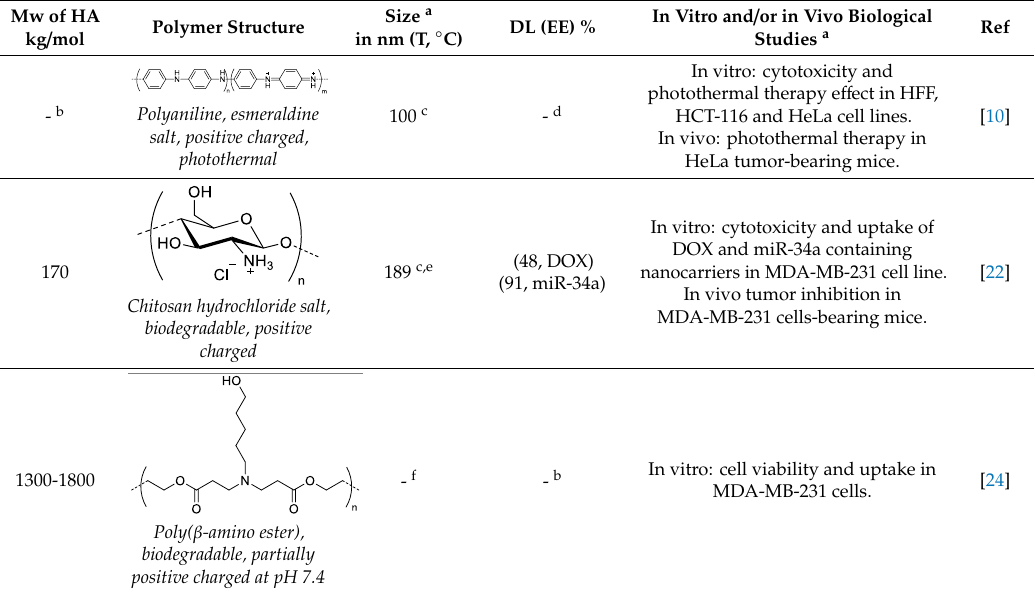
Table 3. Nanocarriers based on HA-polymer complexes.